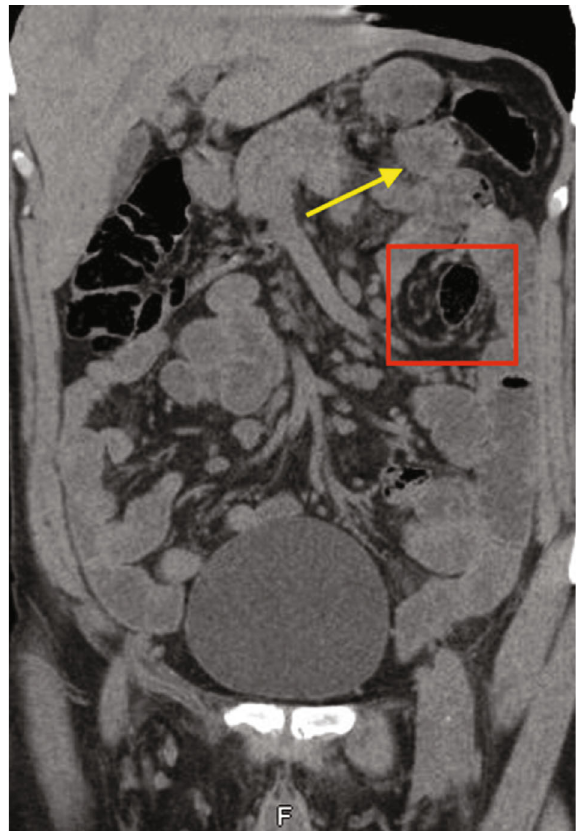
Figure 2: NCCT abdomen showing left lumbar regional mesenteric swirling sign (red box), and mildly dilated abnormally located proximal jejunal loops at the left upper quadrant (yellow arrow).